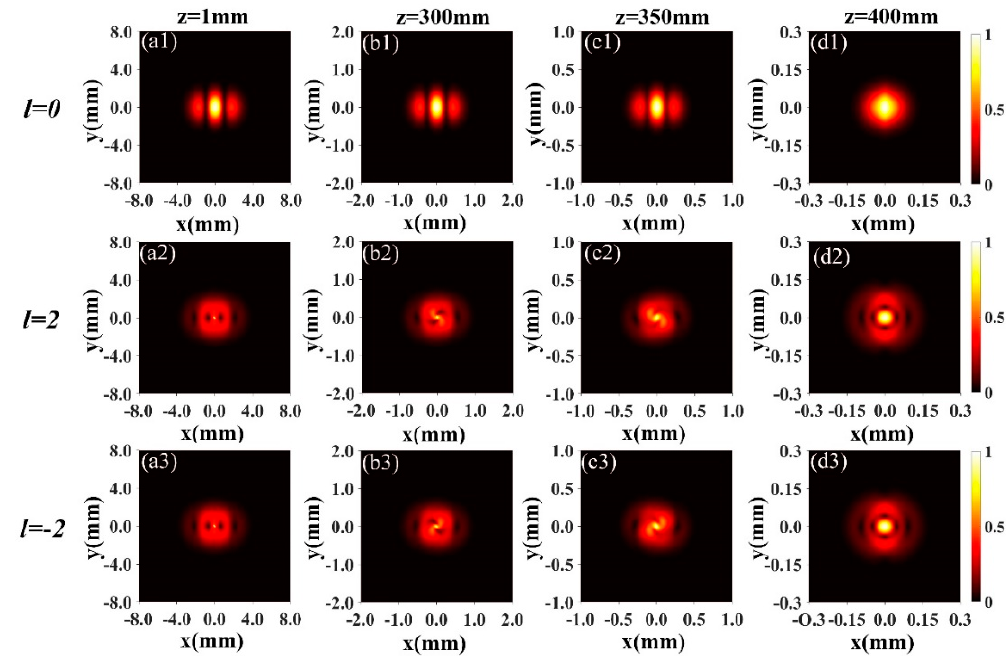
Figure 5. The modulus of the DOC ( with 0 m = , 1 n = and increasing values of the TC.